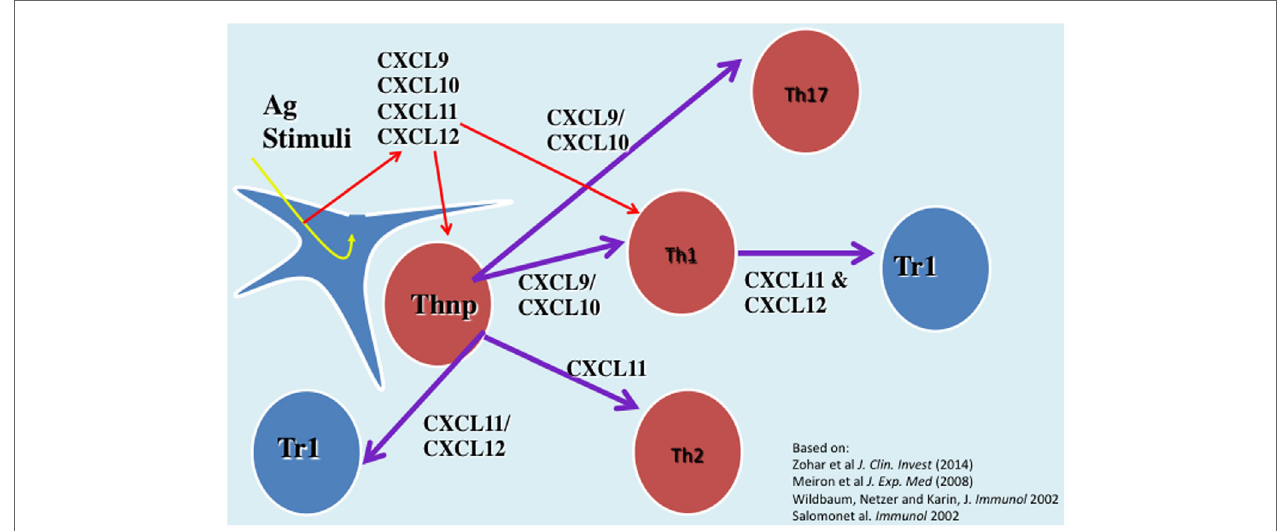
FiGURe 1 | The role of CXC chemokines in driving the polarization and biological function of CD4 + T cell subsets